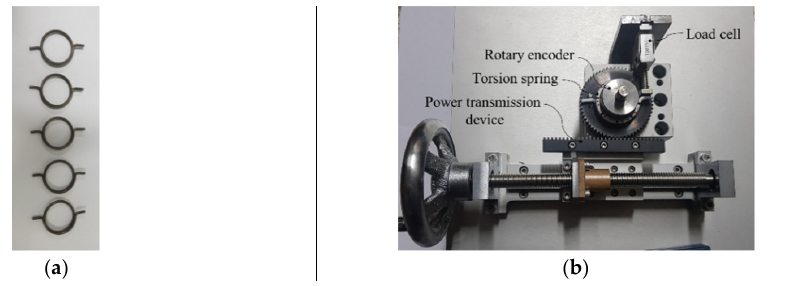
Figure 5. Springs and experiment setup: ( a ) torsion springs; ( b ) experiment setup.